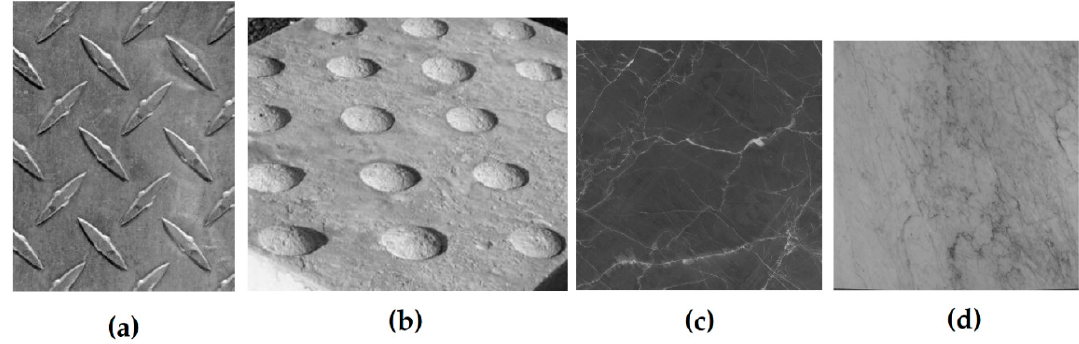
Figure 9. The test images from the highly textural dataset: ( a ) bumpy_0129, ( b ) bumpy_0148, ( c ) marbled_0128, and ( d ) marbled_0132.